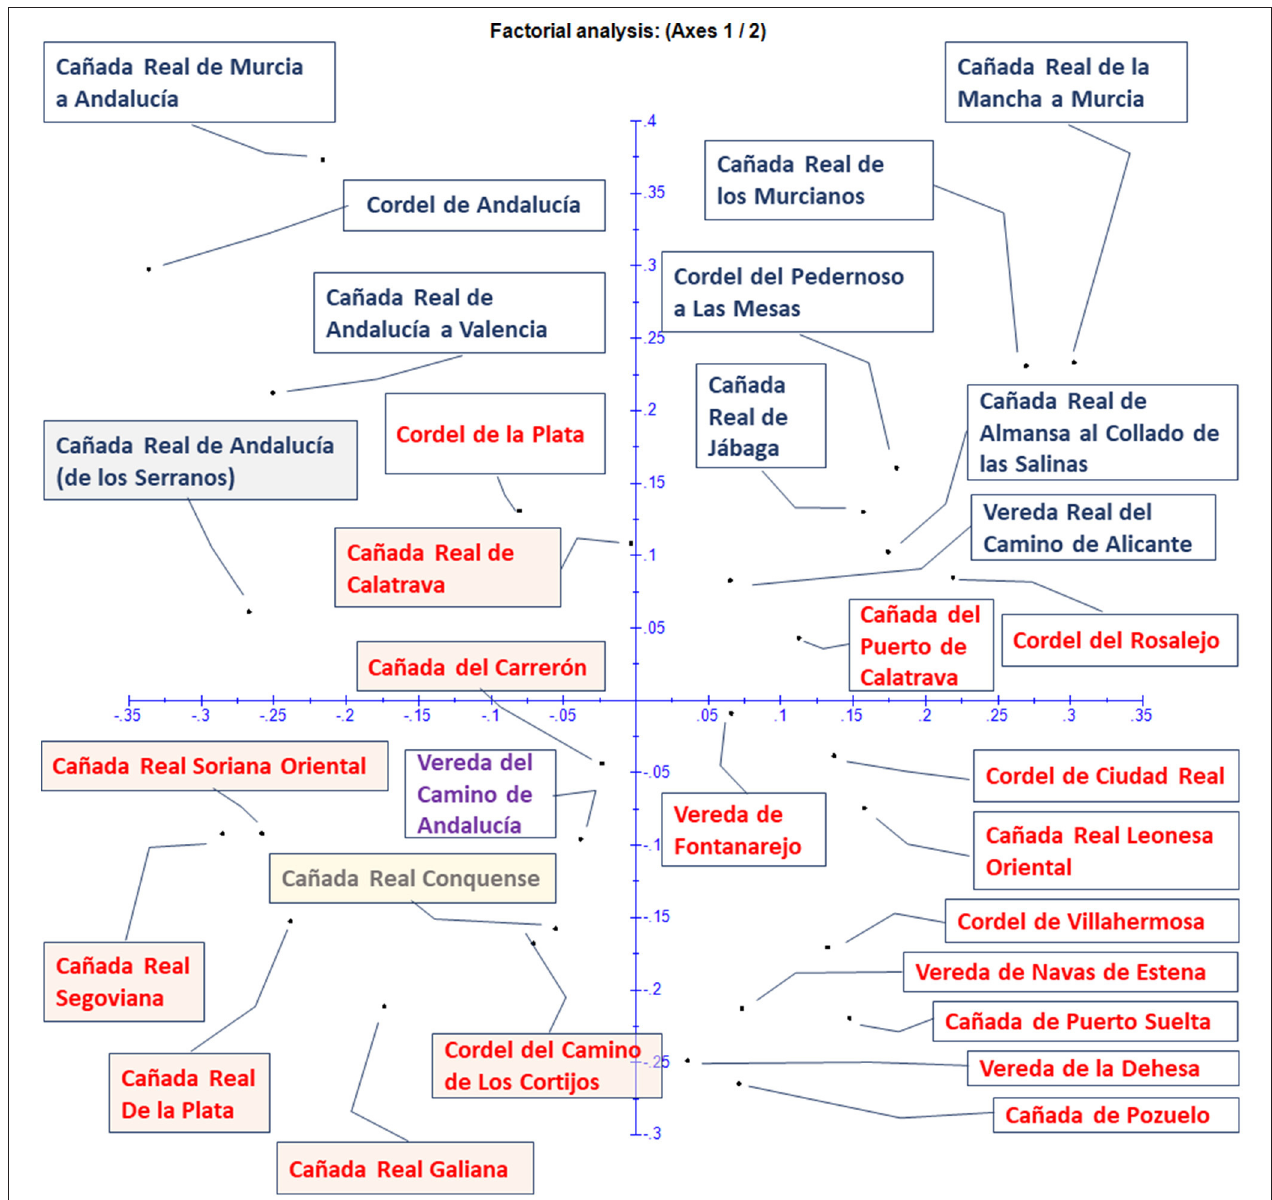
FIGURE 5 | Factorial analysis (PCoA) of relationships between transhumance roads based on the ingredients. Western roads in red characters. Eastern roads in blue